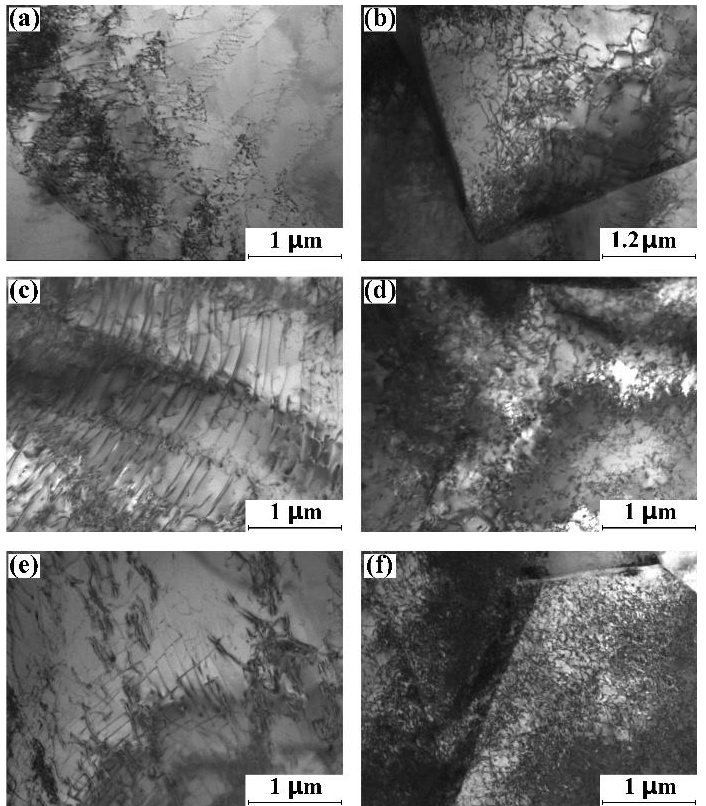
Figure 6. TEM micrograph of the dislocation structure of the mill-annealed Ti-6Al-4V alloy plate after the strain-limited ( ε = 10%) dynamic compression test. The loading direction is parallel to the normal direction of the TEM micrograph. ( a ) Dislocation pile-up for the globular α grain of RD specimen, ( b ) dislocation tangling for the fine equiaxial α grain of RD specimen, ( c ) dislocation pile-up for the globular α grain of TD specimen, ( d ) dislocation tangling for the fine equiaxial α grain of TD specimen, ( e ) dislocation pile-up for the globular α grain of ND specimen, ( f ) dislocation tangling for the fine equiaxial α grain of ND specimen.